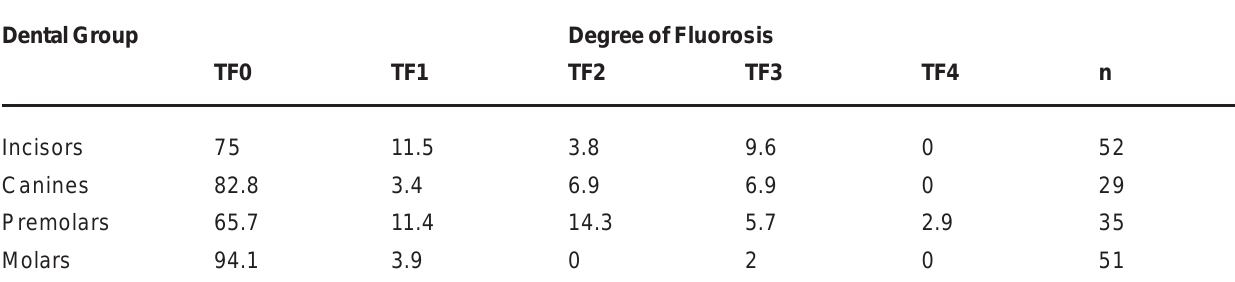
TABLE 3- Percentages of the different degrees of dental fluorosis, according to tooth group, in schoolchildren in a district of Bauru. Dental Group